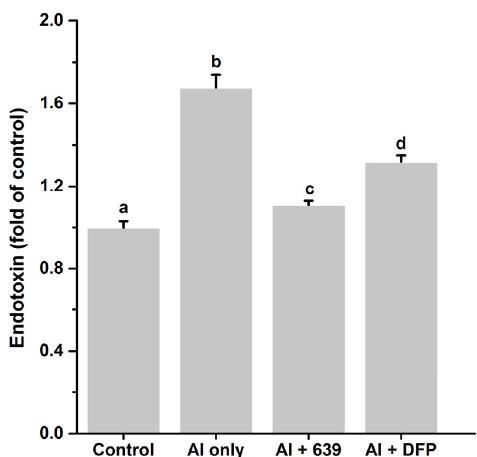
Figure 5. Effects of L. plantarum CCFM639 on Al-induced alterations of endotoxin level in serum of mice. Values are expressed as fold change versus control group and presented as the mean ± SEM. The different letters a–d indicate statistically significant changes among four groups ( p < 0.05).